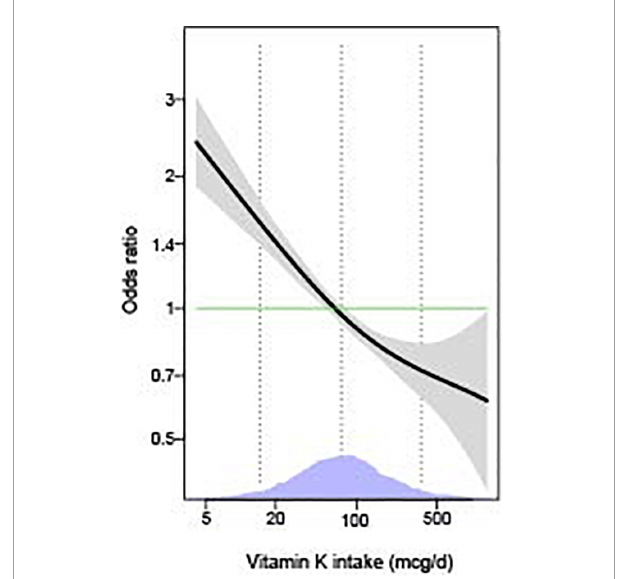
FIGURE2 The associations of vitamin K with depressive symptoms by generalized additive models ( n = 11,687). The models were adjusted for age (18–44, 45–59, or ≥ 60 years), sex (men or women), race/ethnicity (Mexican American, other Hispanic, non-Hispanic White, non-Hispanic Black, or other Race-Including Multi-racial), marital status (married/partner, widowed/divorced, or never married), educational status ( < high school, high school/GED, or > high school), PIR ( < 1 or ≥ 1), home status (owned or being bought, rented, or other arrangement), BMI ( < 25, 25–29.9, or ≥ 30 kg/m 2 ), smoking status (every day, some days, or not at all), physical activity (no and low or moderate and high), sleep disorders (yes or no), hypertension (yes or no), hyperlipidemia (yes or no), and diabetes (yes or no). The solid lines show OR and the shaded areas 95% CI. The dashed lines show OR by linear regression on logarithmic scale. Density plots indicate the distributions of log-transformed vitamin K intake, and dotted lines denote the 10, 50, and 90 th percentiles. BMI, body mass index; GED, General Educational Development; PIR, ratio of family income to